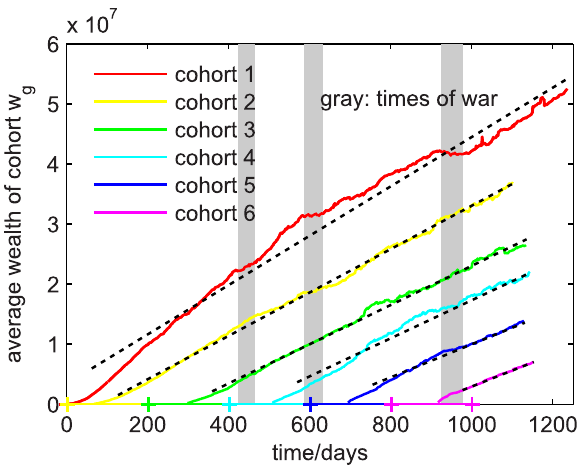
Figure 4. Cohort wealth as a function of time. Cohort 1 ( G 1 ) contains all players who joined Pardus on the first day. Cohort 2 ( G 2 ) contains all players you joined between day 2 and 200, cohort 3 ( G 3 ) all who joined between day 201 and 400, etc. Wealth w g , j ( t ) of cohort G j at time t is calculated as w g , j ( t ) ~ S w i t { t 0, i z (cid:2) tt 0, j (cid:7) (cid:8) T i [ G date at which player i joined the game and (cid:2) tt 0, j : S t 0, i T i [ G cohort entry time. Gray areas mark times of war, dashed lines represent linear fits omitting the transient first 60 days.